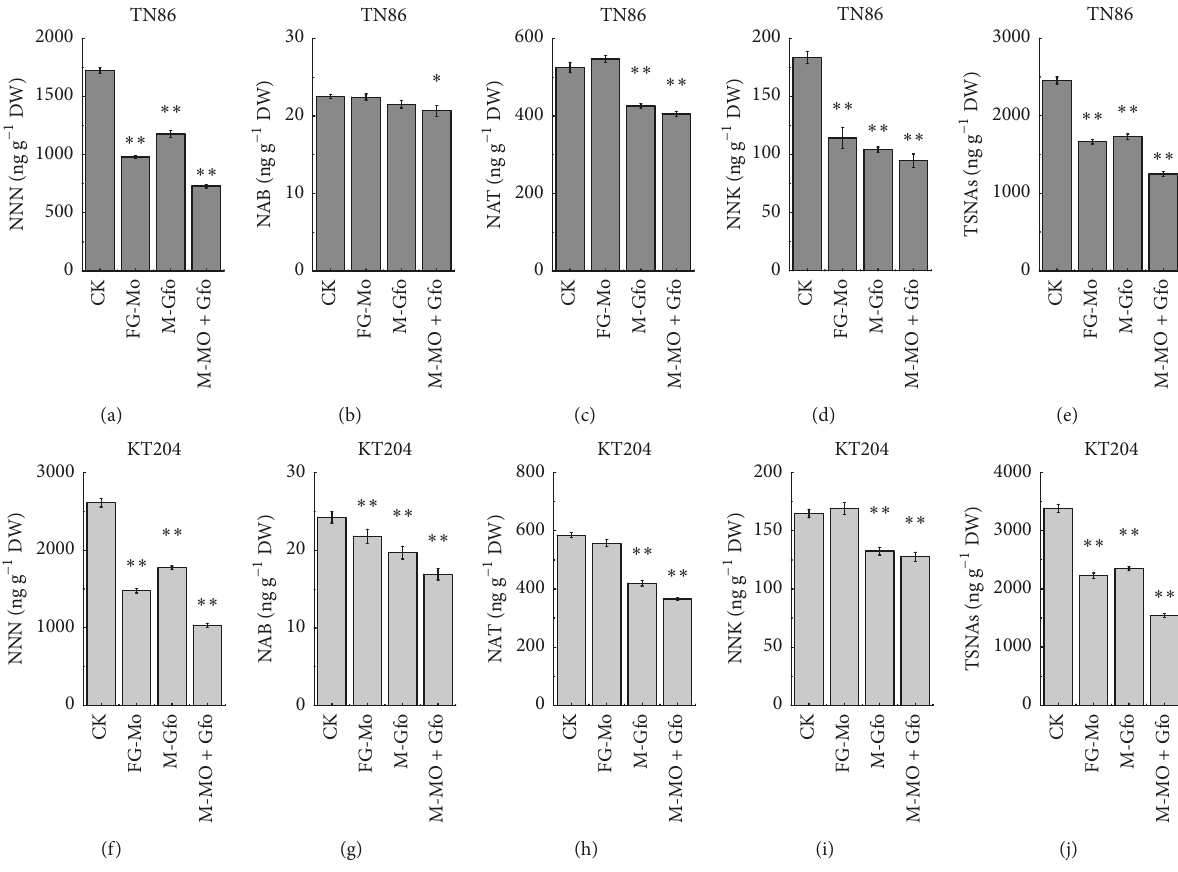
Figure 6: Effects of chemical regulation on NNN, NAB, NAT, NNK, and total TSNA concentration in burley tobacco varieties, TN86 and KT204. Error bars represent standard error ( 𝑛 = 3 ). Symbols ∗∗ and ∗ indicate significant difference at 0.01 or 0.05, respectively.